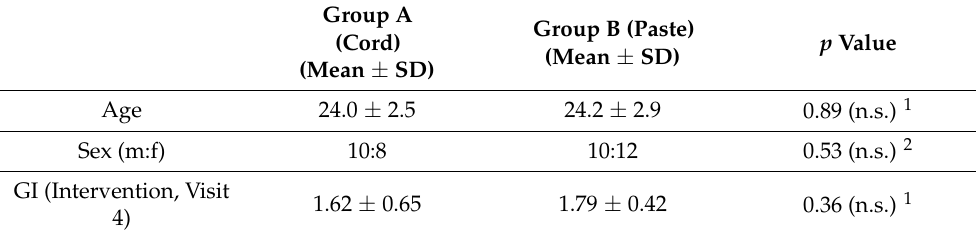
Table 1. Baseline data for group A (cord) and group B (paste).